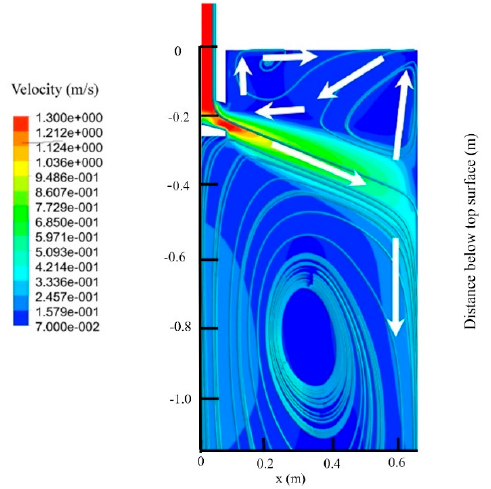
Figure 5. Fluid velocity and streamlines in the mold.